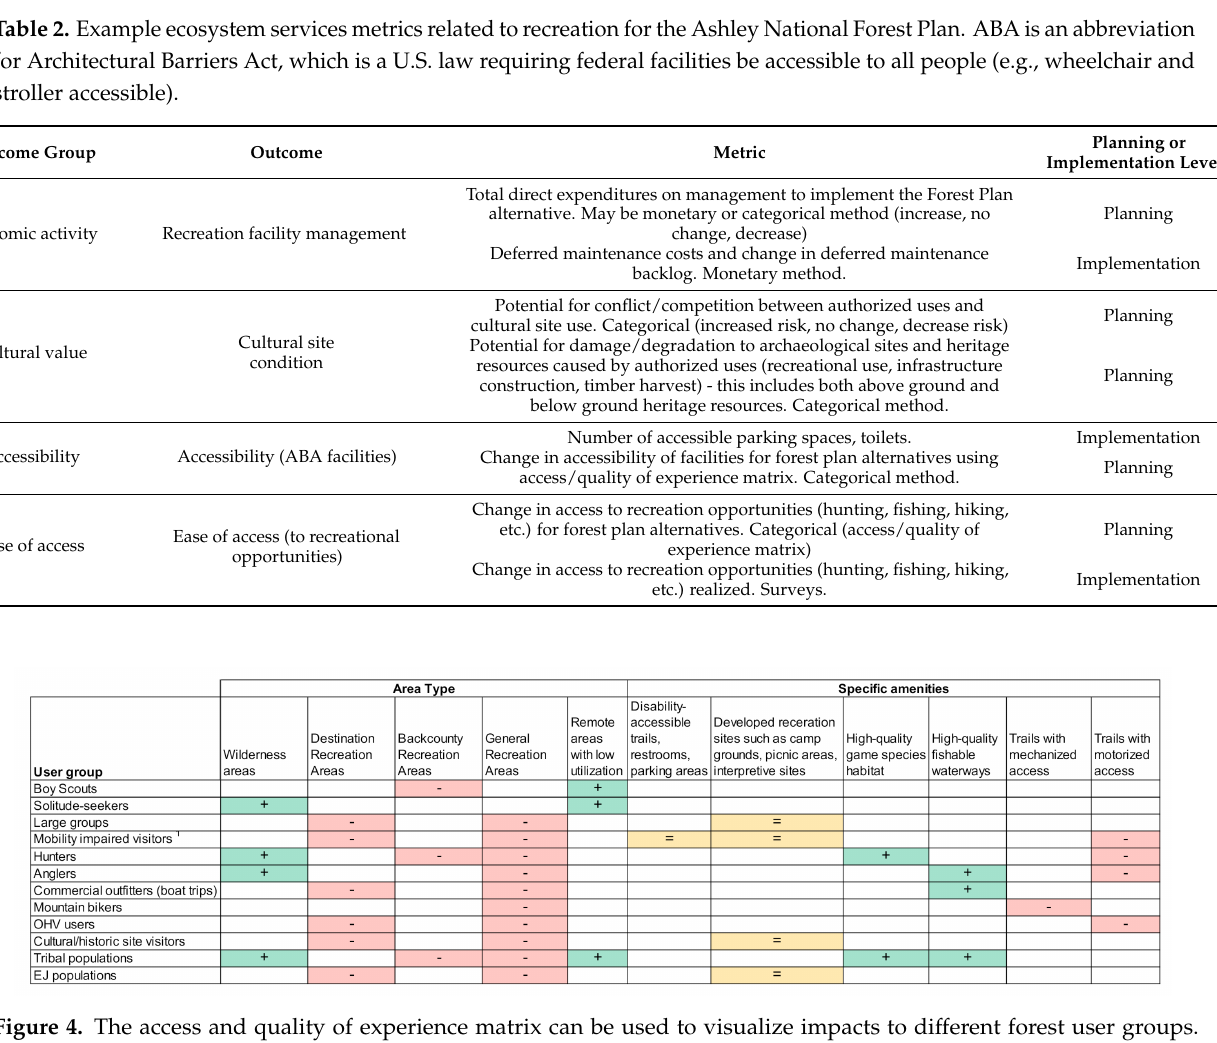
Figure 4. The access and quality of experience matrix can be used to visualize impacts to different forest user groups. Shaded cells at the intersection of a user group (rows) and area or amenity types (columns) indicate that the user group cares about that area or amenity. The colors indicate the direction of the effect that the Forest Plan alternative is expected to have on each type of use area and amenity, and therefore on interested user groups. This is a hypothetical example for the conservation focused planning alternative, with a focus on non-motorized recreation in backcountry, proposed wilderness areas and other undeveloped areas and reduced emphasis on recreation infrastructure development, compared to the no-action alternative. 1 Including those with mobility disabilities and elderly